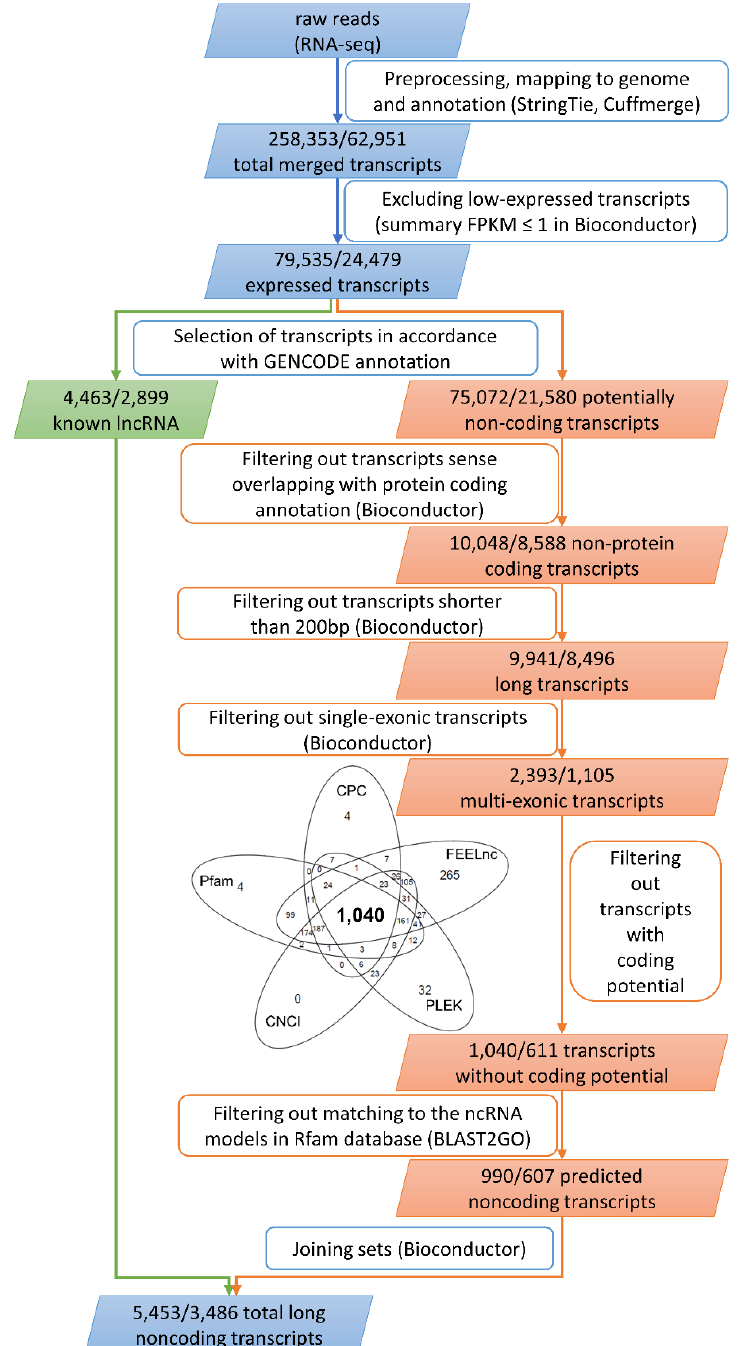
Figure 1. Identification and classification pathway of known (green) and novel (orange) long non-coding RNAs (lncRNAs) expressed in human term placenta; common stages of analysis (blue) join both paths. Numbers in parallelograms refer to amount of lnc transcripts/lncRNA loci. Rectangles show processes and applied tools. Venn diagram presents a number of transcripts without coding potential assigned by Coding-Non-Coding Index (CNCI), Coding Potential Calculator (CPC), FEELnc, Pfam, and PLEK software.